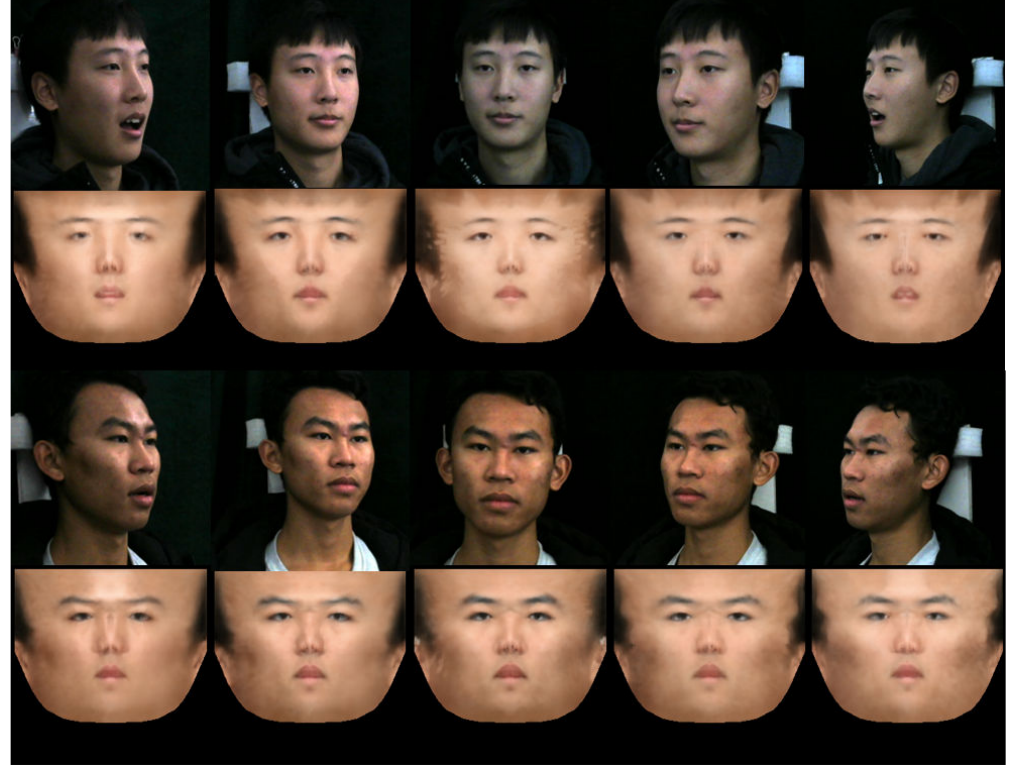
Figure 5. Albedo UV maps recovered by our 3D face modeling module for two subjects in the database constructed by ourselves with different expressions, illuminations, and